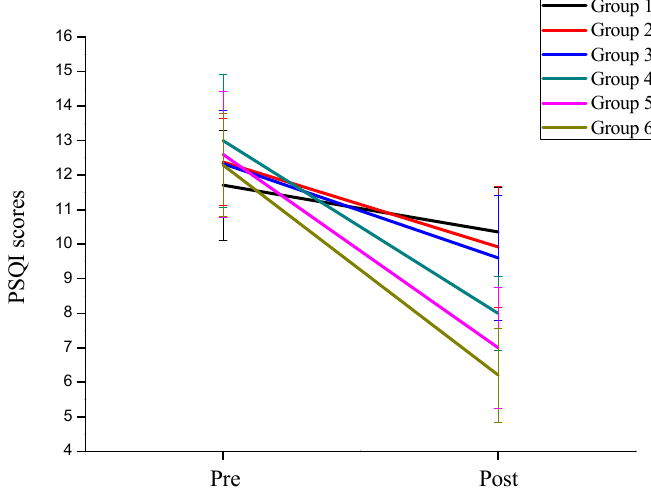
Figure 5. The trend of sleep quality of the six groups of subjects.